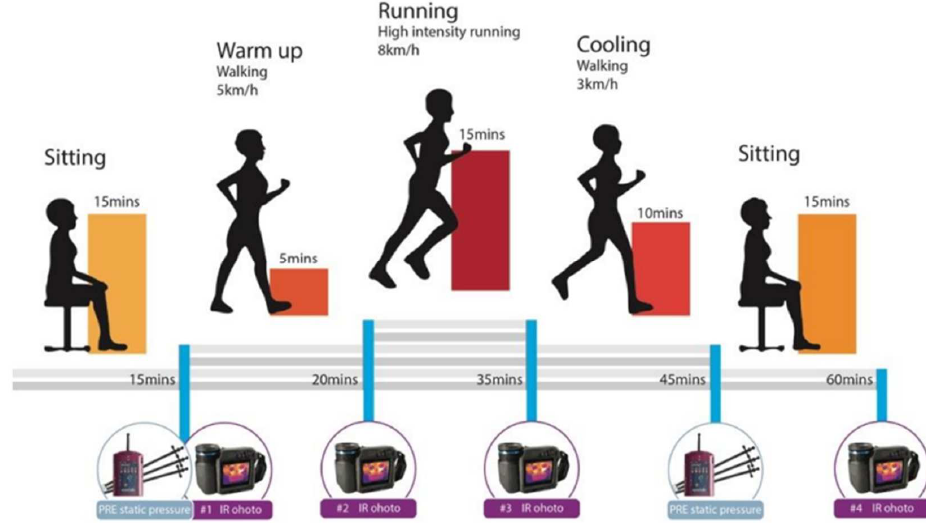
Figure 4. Protocol design of treadmill exercise session.